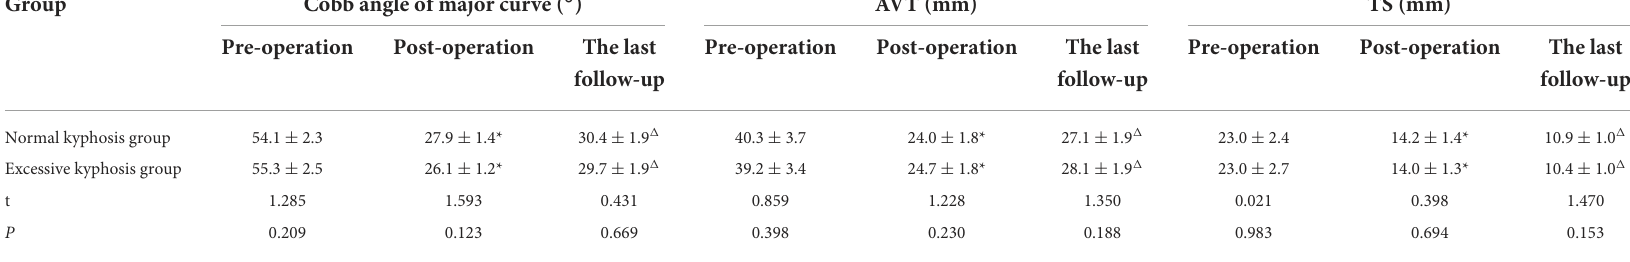
TABLE 2 Comparison of coronal plane indexes on X-ray radiograph of the entire spine in standing position between the two groups ( ¯ x ± s ). ◦ Group Cobb angle of major curve ( ) AVT (mm) TS (mm) Pre-operation Post-operation The last The last Pre-operation Post-operation The last follow-up follow-up follow-up